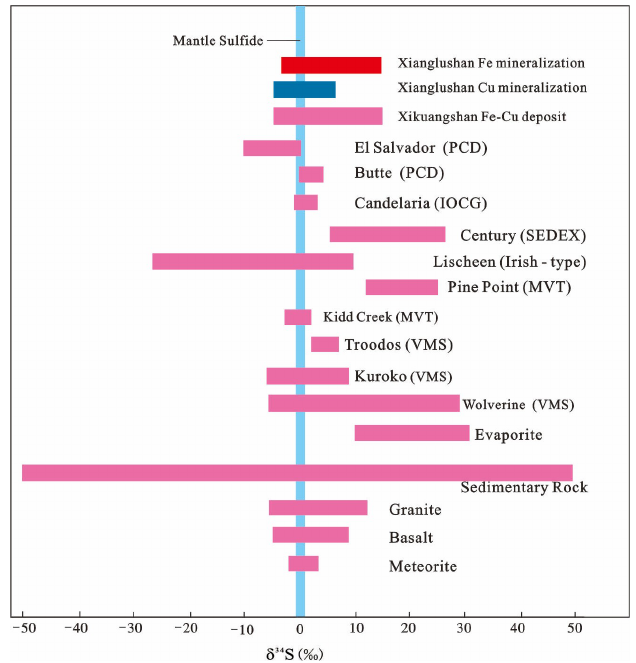
Figure 11 Figure 11. δ 34 S values for sulfides from Xianglushan Stage II pyrite and Stage III chalcopyrite, data from selected base metal deposits, seawater, and rock types around the world, are shown for comparison (e.g., [37–39], and references contained therein).